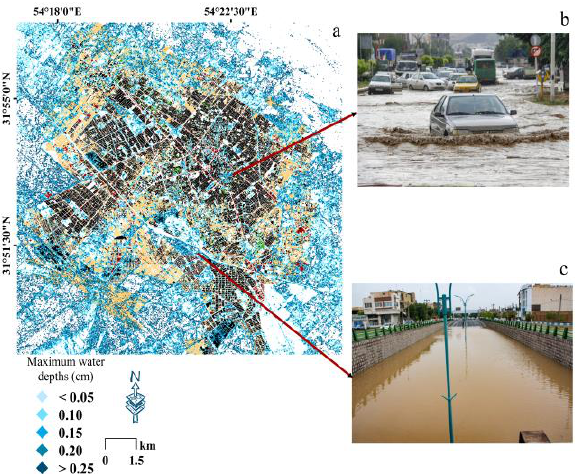
Figure 5. Flood inundation map and depth of water in Yazd city due to event storm July 28-30, 2022 produced by image processing and CNN Classifier (a), images of two flooded places in Yazd city: main street (b) , and railway station